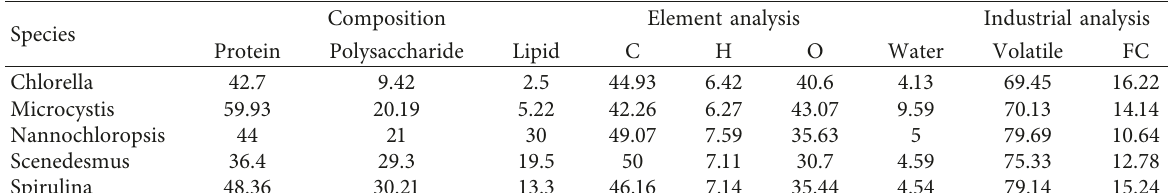
Table 2: The species and compositions of microalgae.